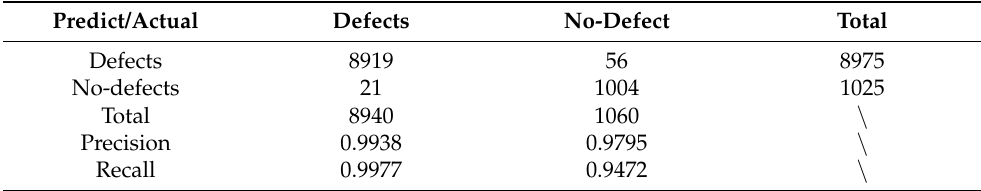
Table 9. Confusion matrix for classification of ‘defect’ and Table 10. Comparison with previous work.